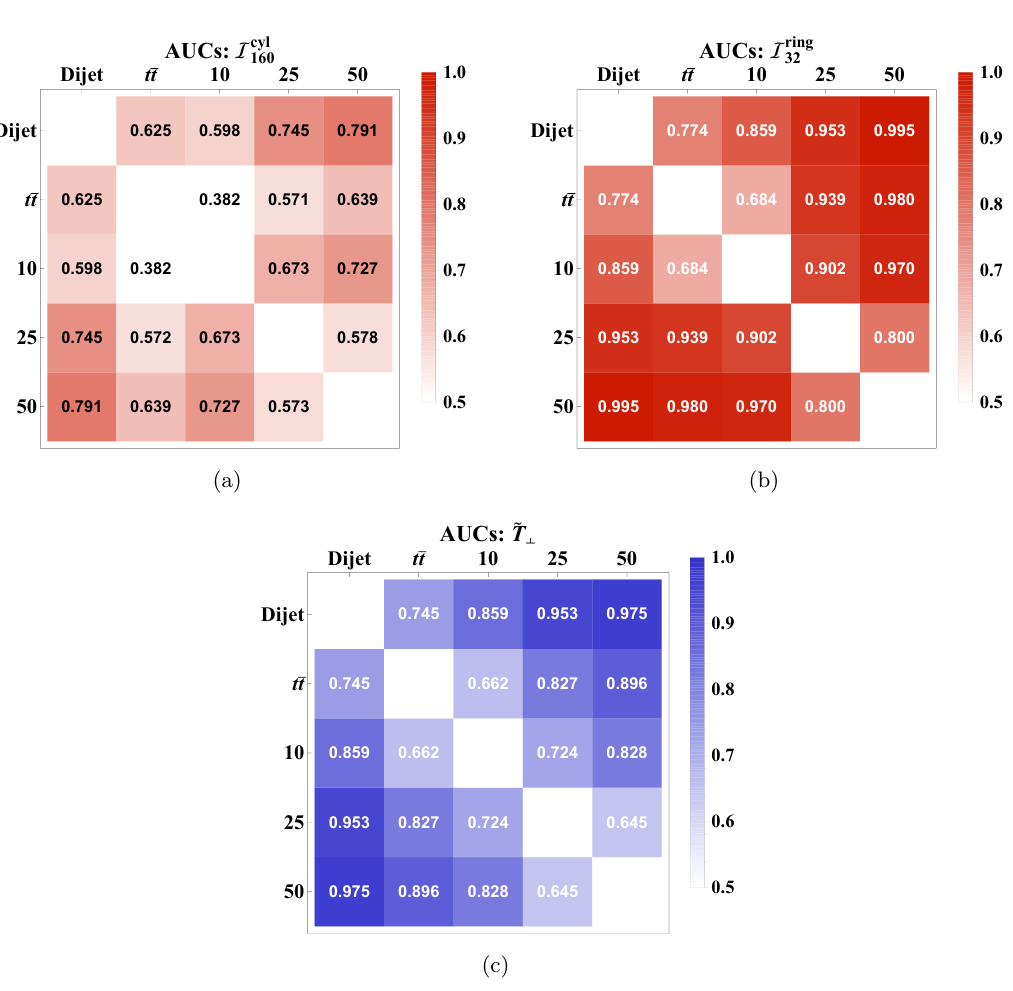
Figure 17 . The discrimination power between each pair of samples plotted in (cid:12)gures 15 and 16, as summarized by the AUC for (a) cylindrical event isotropy with n = 160, (b) ring-like event isotropy with n = 32, and (c) transverse thrust. Darker shades indicate more e(cid:14)cient discrimination. Cylindrical event isotropy is not as powerful of a discriminant as the other two observables which project out longitudinal information. Ring-like event isotropy is the most powerful discriminant for N (cid:29)